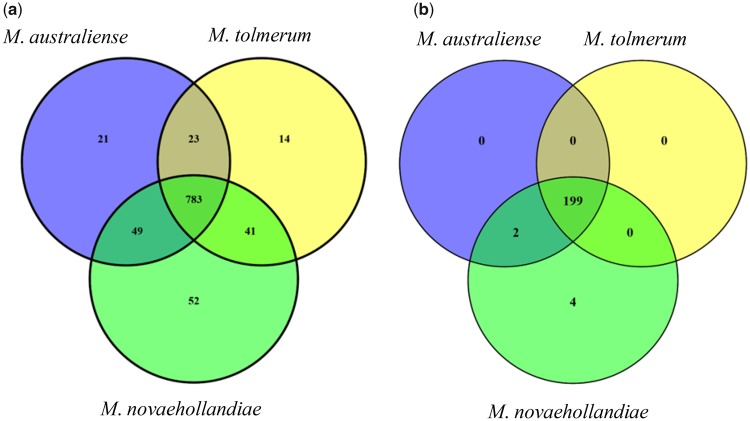
—Venn diagram showing the number of common and species-specific differentially expressed: (a) transcripts and (b) genes. Eight hundred seventy-six transcripts are different isoforms or subunits from 201 genes in Macrobrachium australiense, 861 transcripts from 199 genes in Macrobrachium tolmerum, and 925 transcripts from 205 genes in Macrobrachium novaehollandiae.